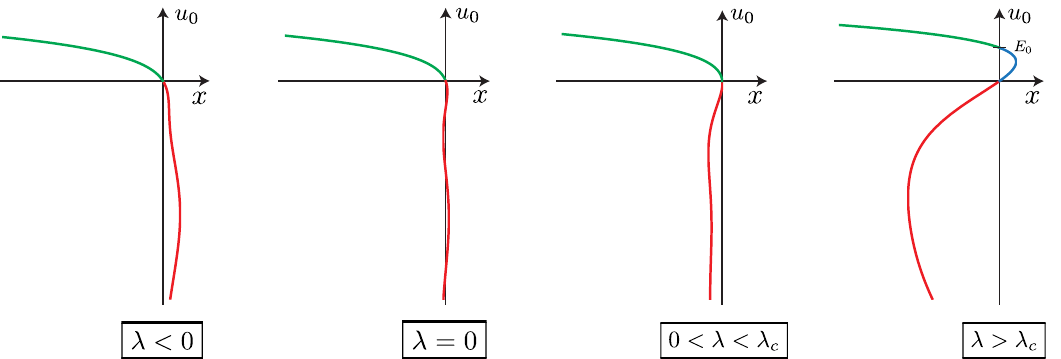
Figure 4. Examples of the curve x = x ( u 0 ) obtained from (3.16) in the ( x, u 0 ) plane for several values of λ and ( α 1 , α 2 ) = (1 / 4 , 1 / 3) . The green curve is the unique choice that yields a single valued function defined in the range x < 0 . While for λ ≤ λ c the green curve always satisfy u (0) = 0 , for λ > λ c we observe u (0) = E 0 > 0